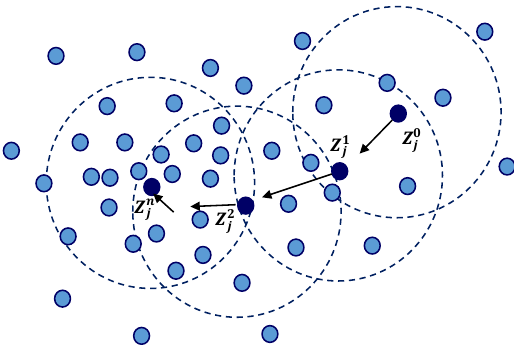
Figure 11. Illustration of the mean shift clustering process [35].